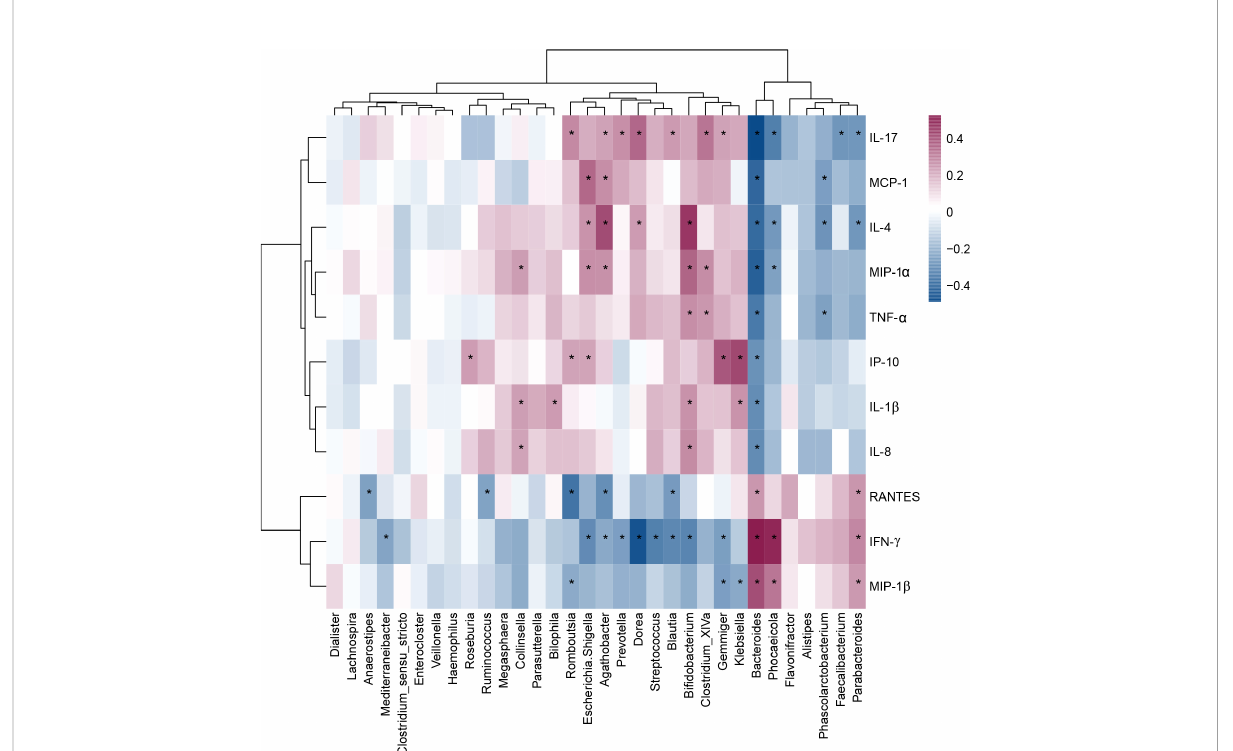
FIGURE 8 Correlation between fecal microbiota, and pro- and anti-in fl ammatory cytokines and chemokines in childhood depression. The heatmap shown Pearson ’ s correlation coef fi cients between differential genera and host immunity in childhood MDD patients. Pearson correlation (r) and probability (p) were used to evaluate statistical importance. *p <